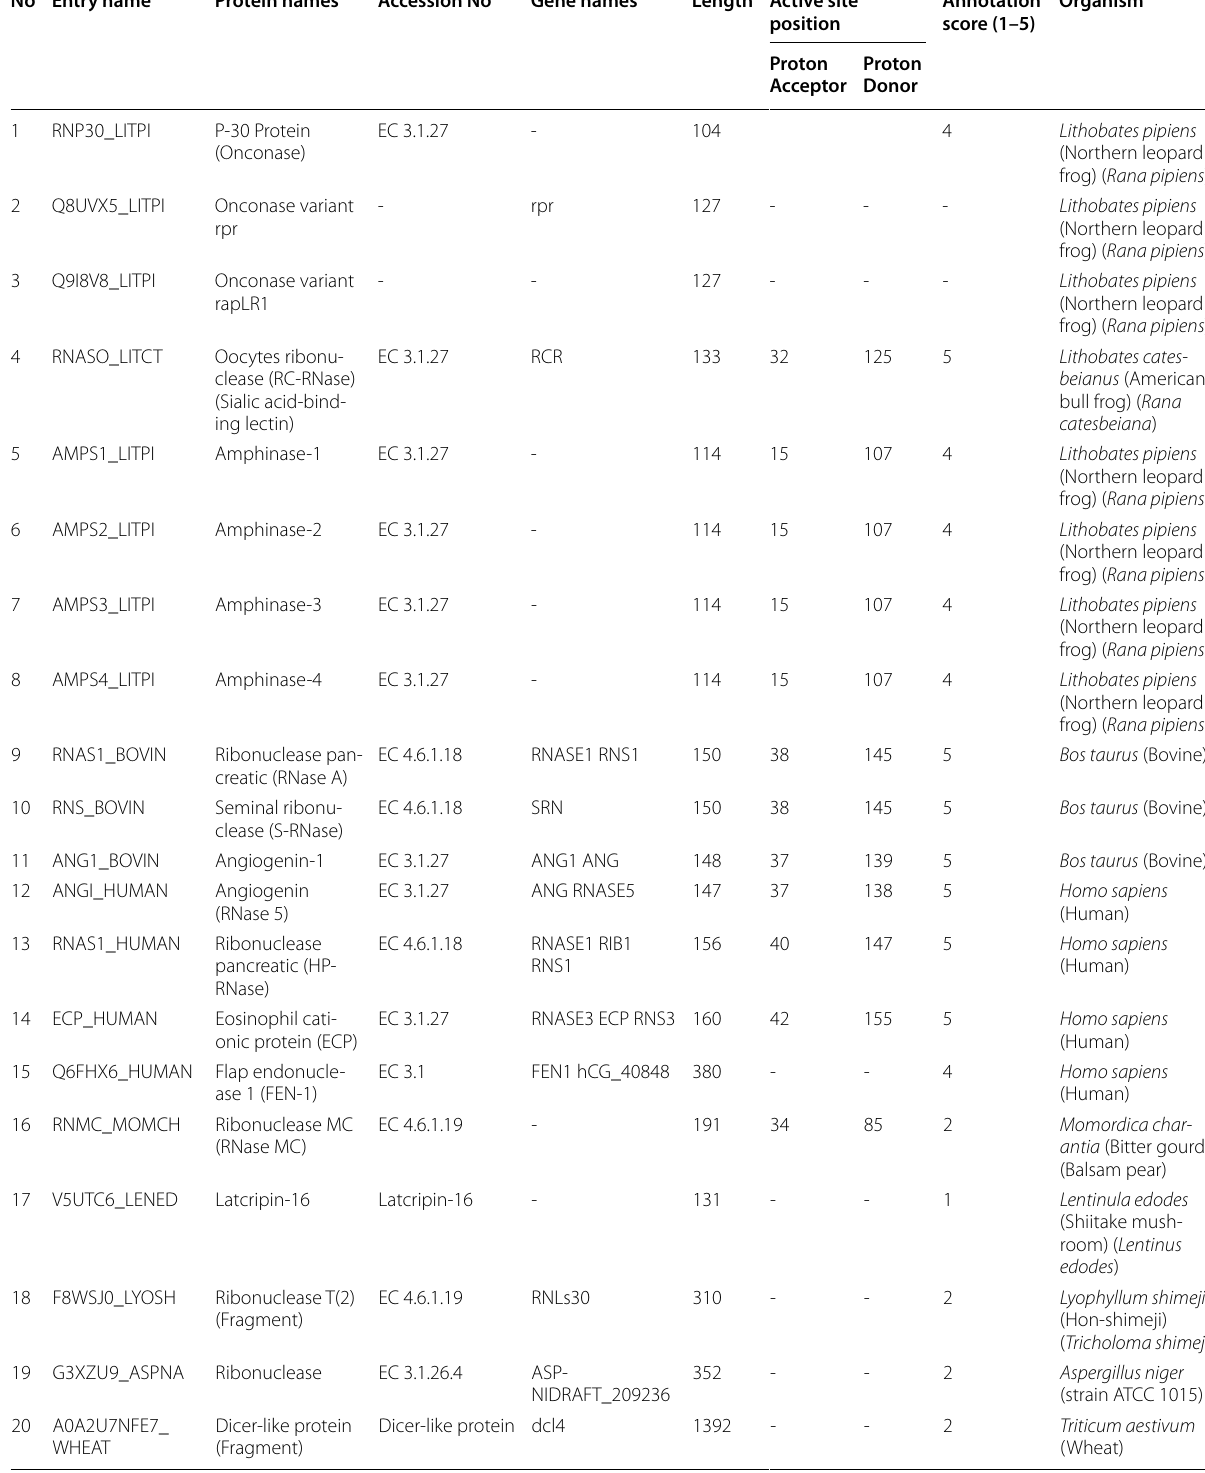
Table 2 UniProtKB search results of anticancer eukaryotic